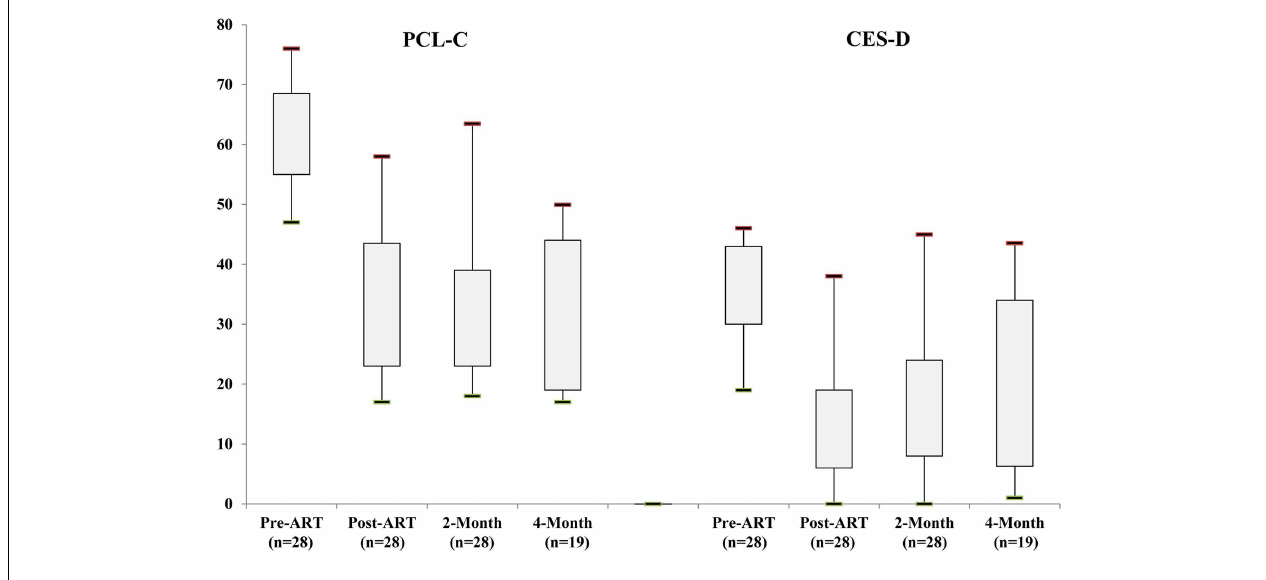
4-month follow-up. The rectangles depict the interquartile range; the lower and upper ends of vertical lines depict the fifth and ninety-fifth percentiles,